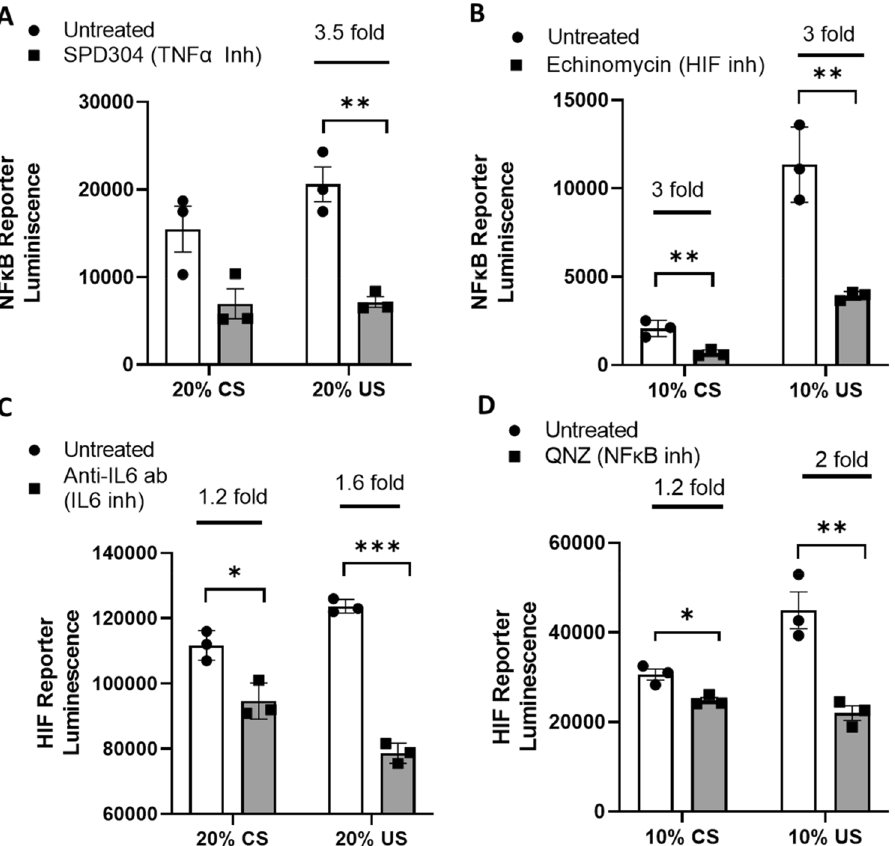
Figure 3. Activation of HIF and NFκB in uremia is blunted by inflammatory cytokine inhibition. NIH/3T3 cells expressing NFκB luciferase reporter were incubated with different concentrations of normal and uremic serum and 5 µM of the TNFα antagonist SPD304 ( A ) or 10 nM of echinomycin which is a HIF-1α inhibitor ( B ). Luciferase activity as reflection of NFκB activation in reporter cells was measured after serum and drug exposure for 24 h. NIH/3T3 cells expressing HIF luciferase reporter were incubated with different concentrations of normal and uremic serum and 2 µg/ml of neutralizing anti-IL6 monoclonal antibody ( C ) or 50 nM of QNZ which is an NFκB inhibitor ( D ). Luciferase activity as reflection of HIF activation in reporter cells was measured after serum exposure for 24 h in normoxia (21% O 2 ). Unpaired t test, n = 3. Experiments were done in triplicate, error bars represent SEM *p ≤ 0.05, **p < 0.01, ***p < 0.001. CS, normal serum; US, uremic